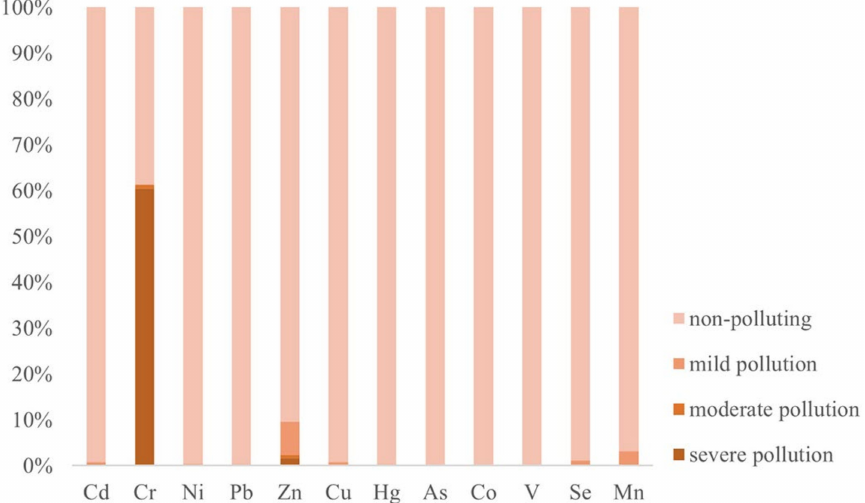
Figure 2. SPIs of the soil heavy metals in the study